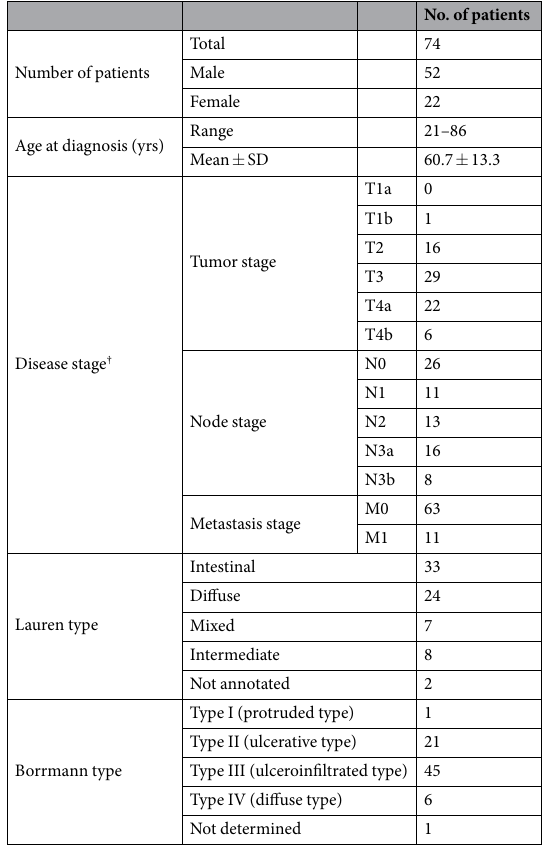
Table 1. Clinicopathological information of 74 advanced gastric cancer patients. † Stage classification follows the TNM classification system by International Union Against Cancer